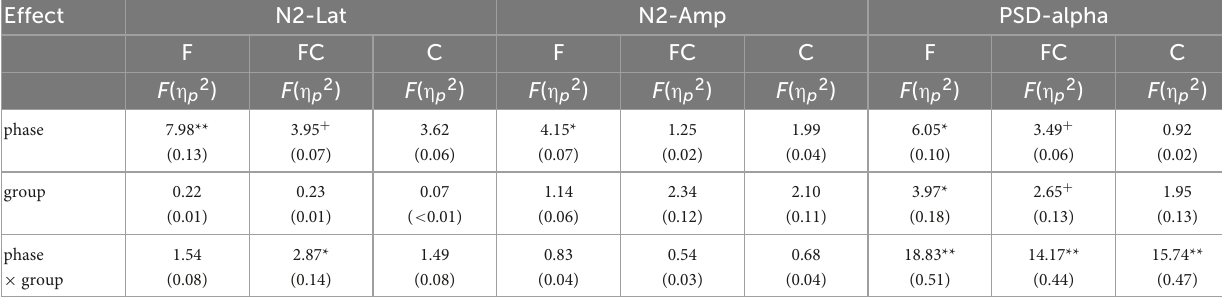
TABLE 2 Summary of rmANOVA results for signal-N2 latency and amplitude, alpha power in